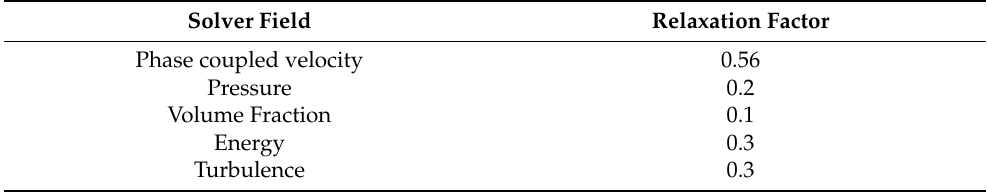
Table 20. Simulation relaxation factor